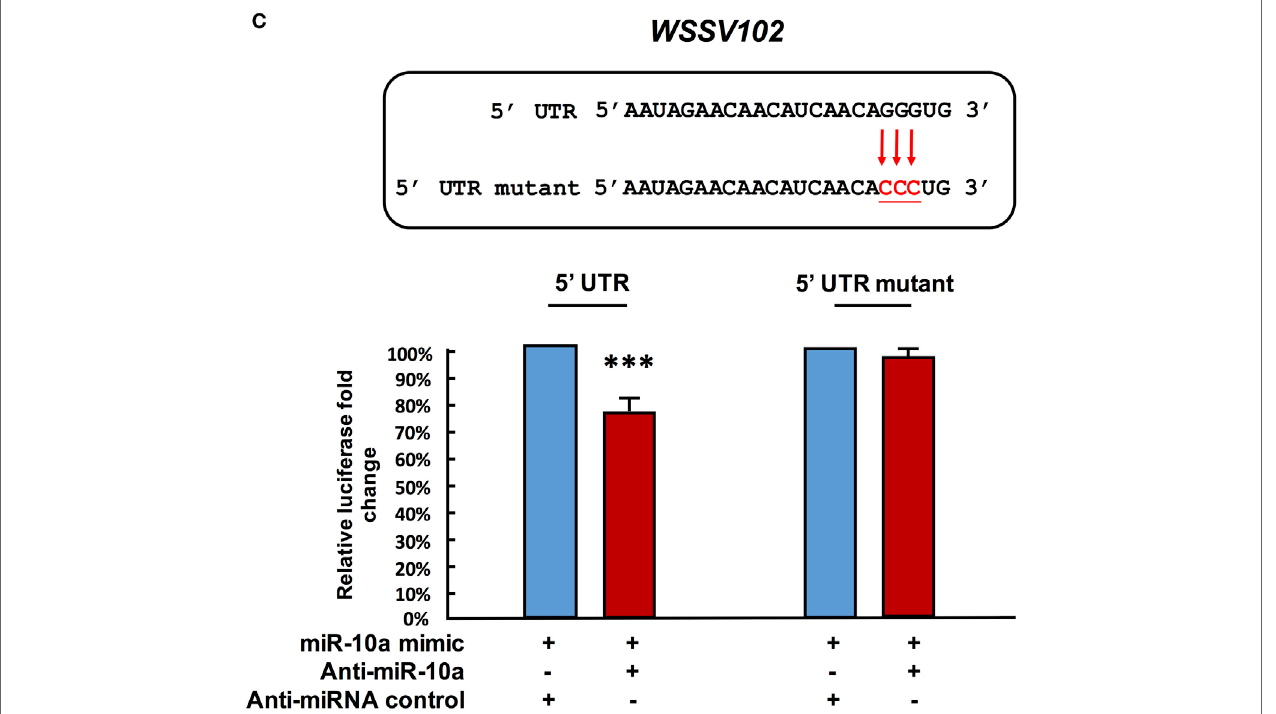
FigUre 4 | Mutation of the target gene’s 5 ′ UTR prevents the downregulation caused by miR-10a suppression. Sf9 cells were transfected with the miR-10a minic (23 pmole) plus 500 ng of the non-mutant or mutant ie1/pGL3/5 ′ -UTR firefly luciferase expression construct for (a) VP26, (B) VP28, and (c) WSSV102, along with either anti-miR-10a (32 pmol) or the anti-miRNA control (32 pmol) as indicated. At 48 h post-transfection, the firefly luciferase signals were normalized relative to those of the Renilla luciferase internal control, and data are shown relative to the anti-miRNA control (set to 100%). Data represent mean ± SD from three independent experiments; * p < 0.05, ** p < 0.01, and *** p < 0.005 by Student’s t -test. The mutated nucleotides are shown in